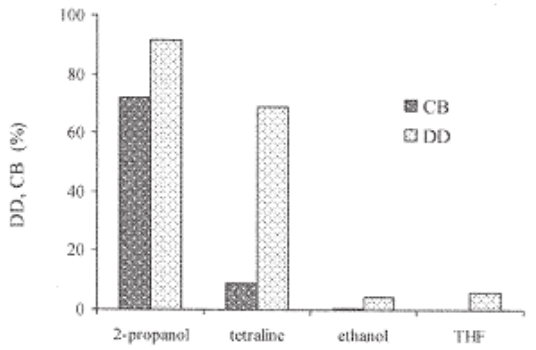
Figure 2. Influence of the different solvent type on dechlorination of PCBs (Dose of irradiation = 40 kGy, [PCBs] = 32 . 6 g dm − 3 , NaOH = 1 . 5 g, temp. 65 ◦ C, CB = conversion of PCB into biphenyl, DD = degree of dechlorination) [7].